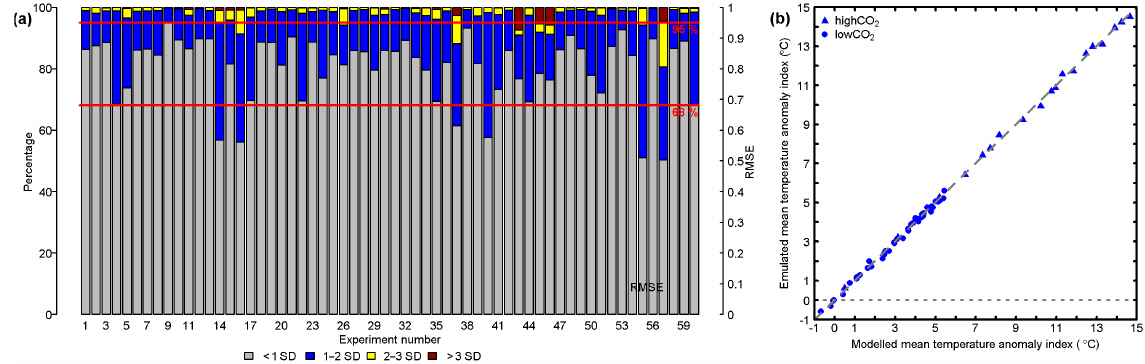
Figure 8. Evaluation of emulator performance. (a) Bars give the percentage of grid boxes for which the emulator predicts the SAT of the left-out experiment to within 1, 2, 3 and more than 3SD (standard deviations). Also shown is the RMSE for the experiments (black circles). Red lines indicate 68 and 95%. (b) Global mean annual SAT index ( ◦ C) calculated by the emulator and the GCM for the low CO 2 (circles) and high CO 2 (triangles) modice ensembles. The 1:1 line (dashed) is included for reference. Note: this is the mean value for the GCM output data grid assuming all grid boxes are of equal size, hence not taking into account variations in grid box area: we therefore refer to it as a SAT index. SAT is shown as an anomaly compared with the pre-industrial control